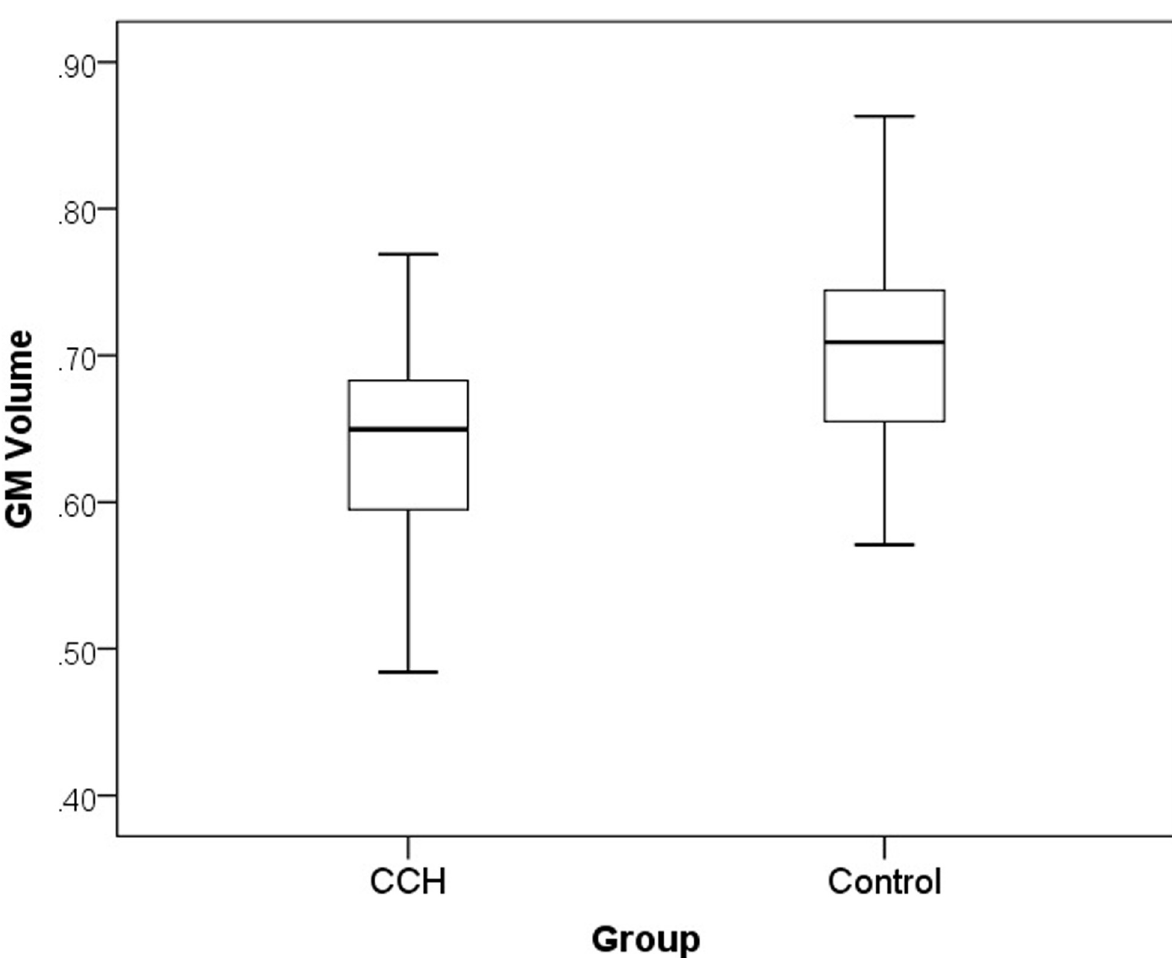
Fig 2. Box plot of grey matter volumes across the whole brain of CCH participants and controls. The central box represents the value from the lower to upper quartile (25th to 75th percentile). The middle line represents the median. The vertical line extends from the minimum to the maximum